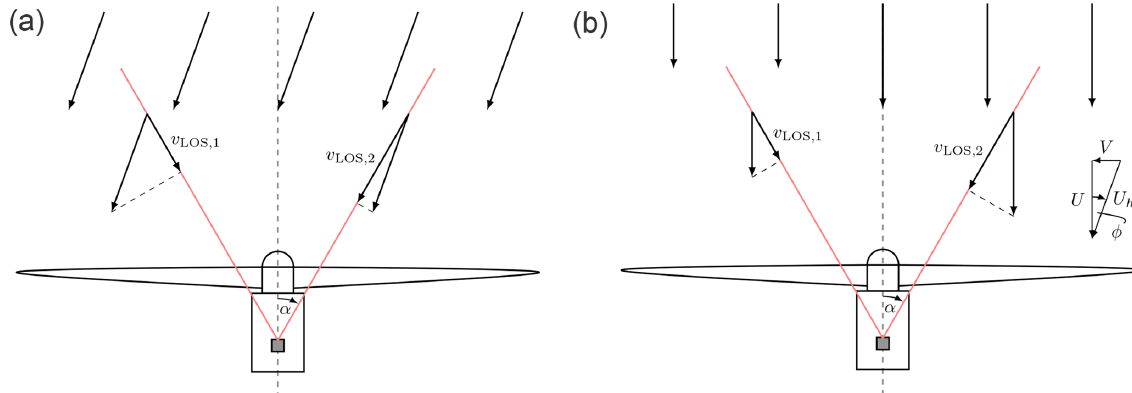
Figure 1. Illustration of a two-beam nacelle lidar mounted on a wind turbine to measure yaw misalignment. Misaligned horizontally homo- geneous flow will affect the LOS measurements at the two focus positions (a) . A wake in the field of view on one of the beams will affect the LOS measurement in a similar way as a misaligned flow (b) . From lidar measurements these two situations cannot be distinguished. The variables are introduced in Sect.